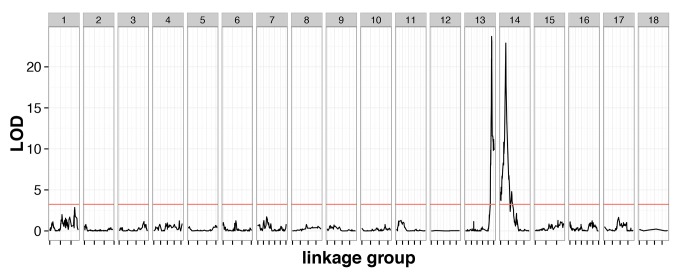
Linkage mapping confirms the existence of two-locus CSD in V. emeryi.Marker locations are shown by short dashes along the x-axis of the plot. A red line shows the permuted 95% significance level of the LOD score. This genome scan found two loci, named CsdQTL1 and CsdQTL2, on LG13 and LG14, respectively. These two loci and their interaction explained 98.0% of the observed phenotypic variance. The two-locus model obtained by QTL analysis is consistent with sex ratio data from the experimental crosses, which find a quarter of diploid males in the F2 offspring (Table 1).